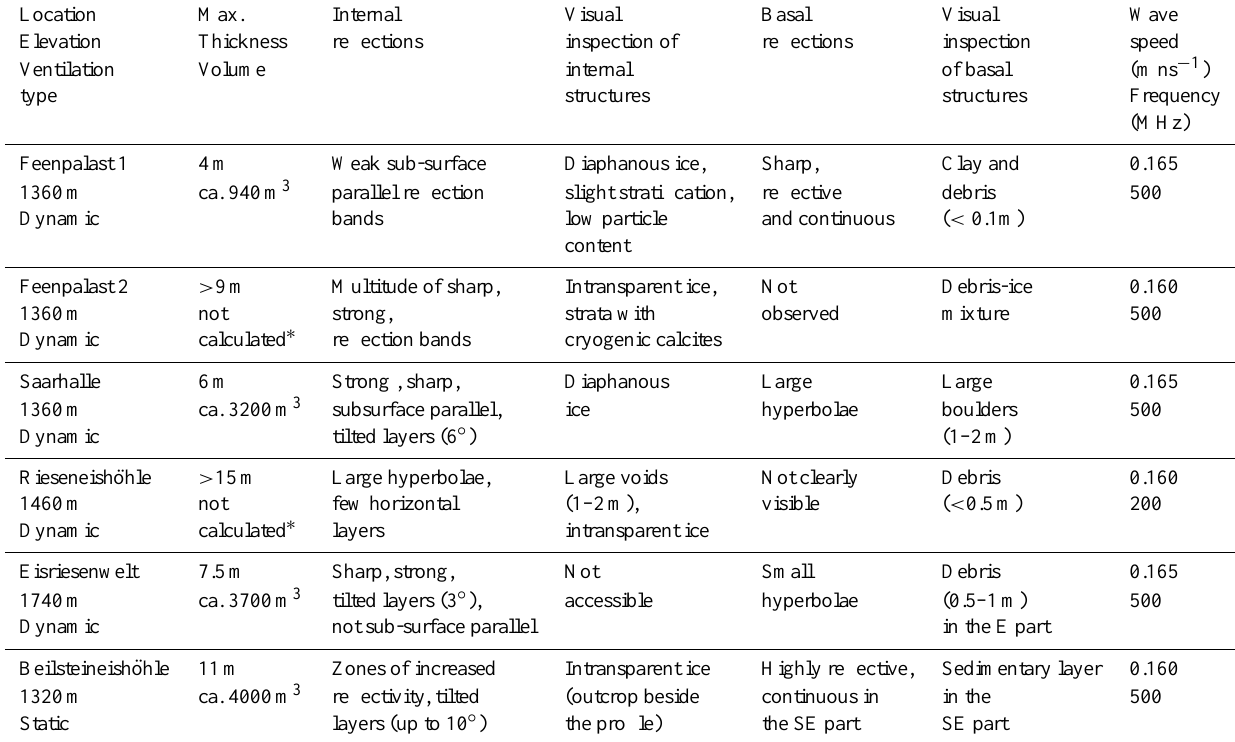
Table 1. Type, elevation, ice thickness and volume, visual inspections and reflection characteristics for the internal and basal structures for the investigated sites. The asterisk denotes locations where the calculation of the volume was not possible (irregular shape of the ice).